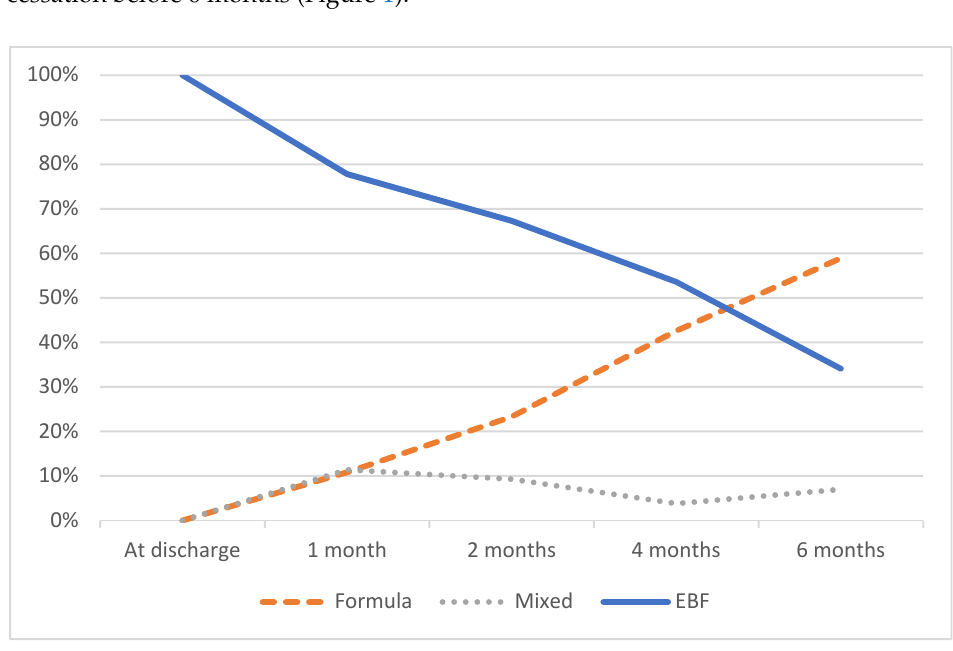
Figure 1. Feeding type during the study period.